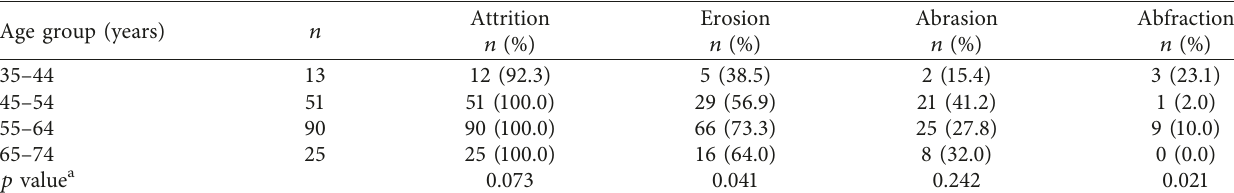
Table 2: Prevalence of tooth wear according to age